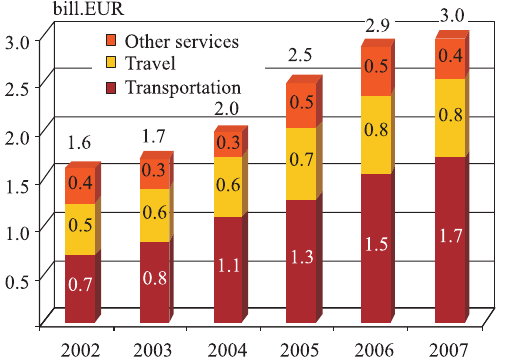
Fig. 5. Th e breakdown of the export of services in Lithuania, bill. EUR